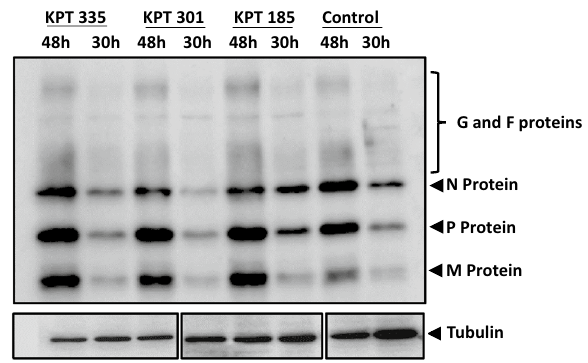
Figure 6. SINE compounds do not impact RSV protein expression. A549 cells were infected at MOI = 1 for 1 h and treated with 1.5 μM KPT-185, 1.5 μM KPT-335 or 50 μM KPT-301 from 2 to 30 h.p.i or to 48 h.p.i. 0.5 μM of DMSO was used as control. The cell lysates were analyzed by Western blotting. The blot was probed with goat α-RSV (1:1000) and rabbit α-Tubulin (1:1000), bound antibody was detected with horseradish peroxidase- conjugated secondary antibody (1:5000) and Enhanced Chemiluminescence (ECL, Perkin Elmer) kit. Images were taken using Li-Cor Odyssey Fc infrared imaging system and Image Studio Lite software. Tubulin was used as loading control. Image is representative of three independent experiments. Please refer to Fig. S2 for full length blots corresponding to the cropped blots presented